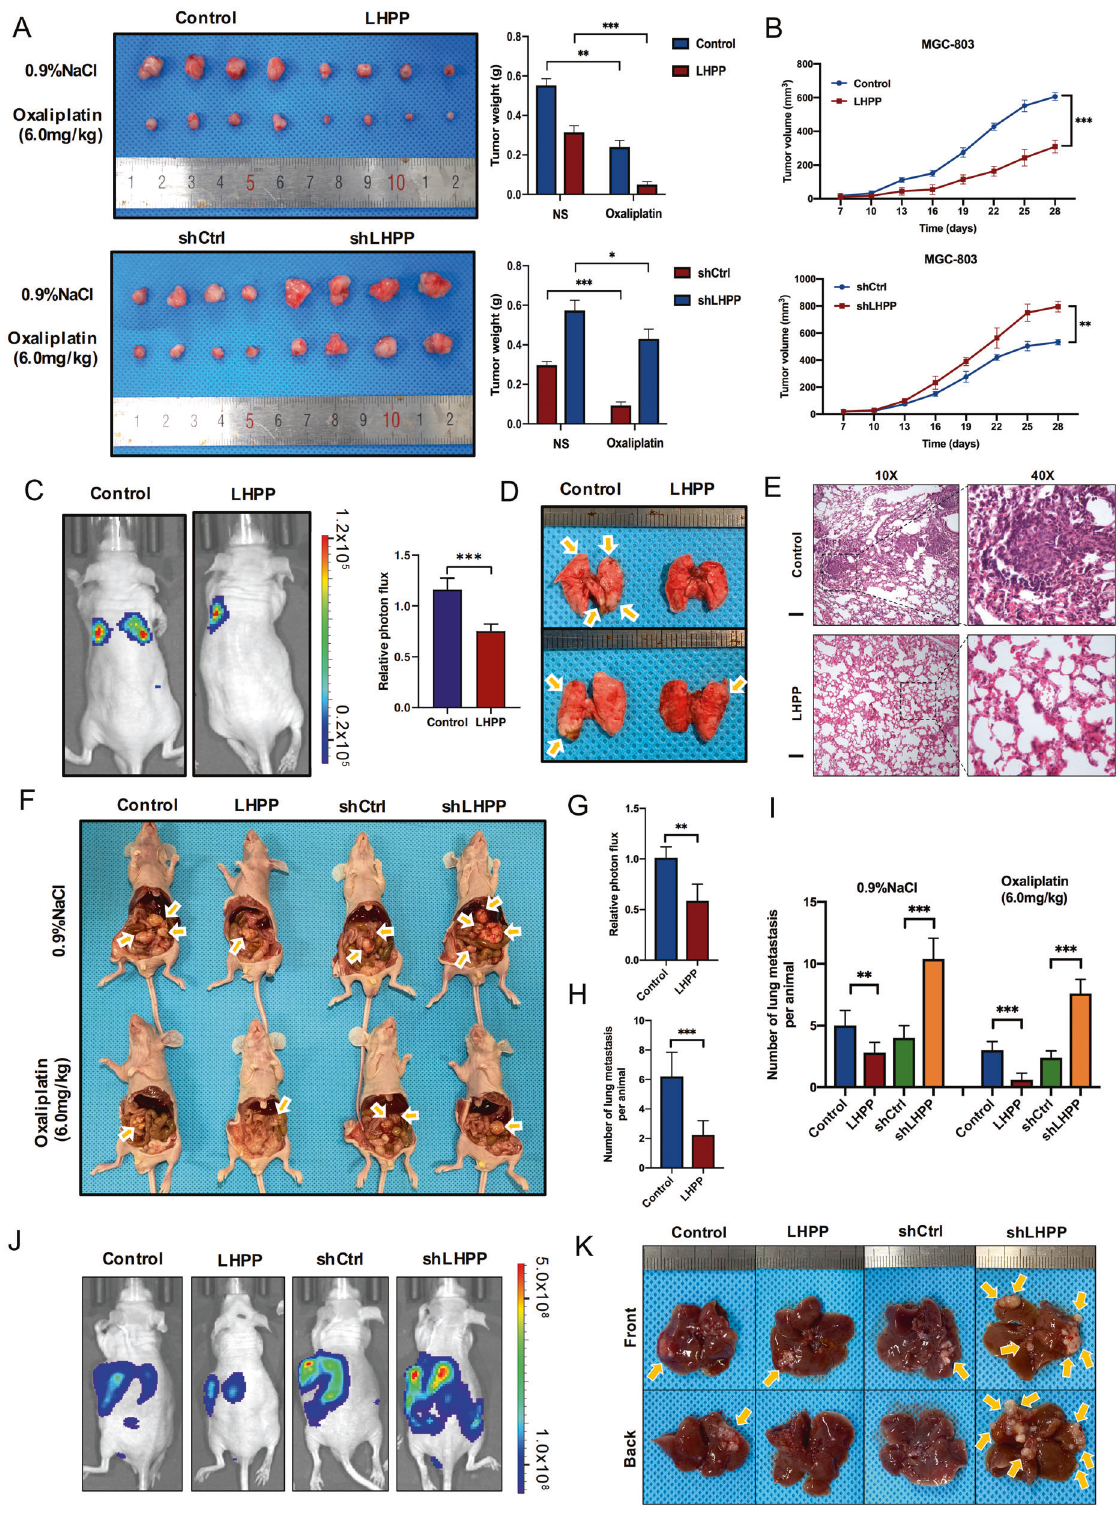
exogenously expressed LHPP (Fig. 5B) in cells treated with trichostatin A (TSA), a broad-spectrum inhibitor of the histone deacetylases (HDAC) family of deacetylases, and nicotinamide (NAM), an inhibitor of the sirtuins (SIRT) family of deacetylases. Using a speci fi c antibody against acetylated lysine, we